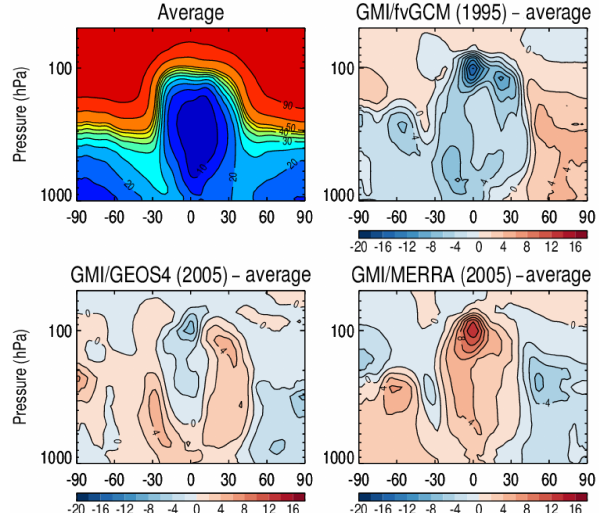
Figure 3. Same as Fig. 2 but for stratospheric fraction (%) of zonal mean tropospheric 7 Be concentrations.